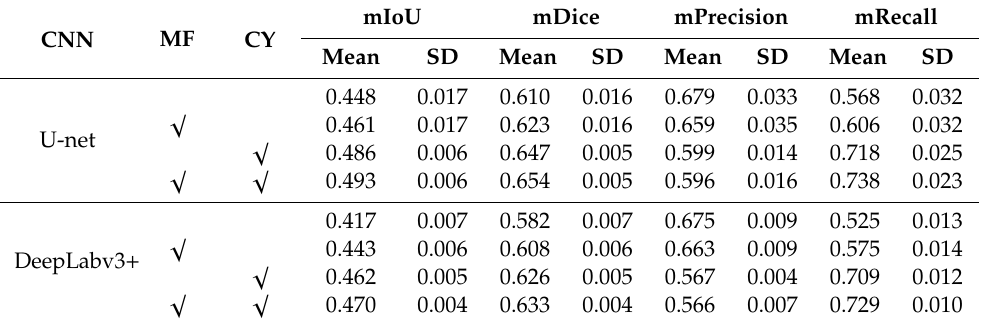
Table 1. Thoracic wall segmentation performance of each set of combinations of MF and CY with the two CNNs.